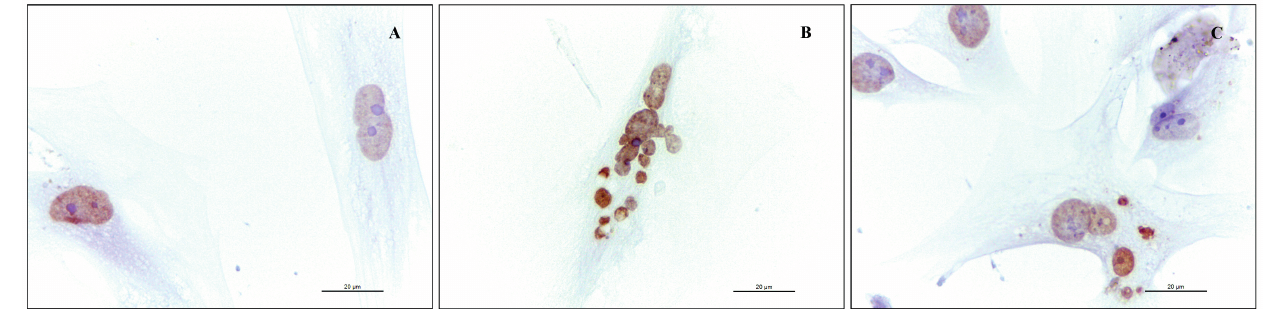
Figure 4. Cytological visualization of apoptosis by TUNEL assay on P20 pre-adipocytes. Nuclei of apoptotic cells are marked in brown, counterstained with Gill’s hematoxylin. ( A ) CTRL cells; the nuclei are clearly positive, partly demonstrating alteration of nuclear membrane; ( B ) RS-treated pre-adipocytes; extrusion of apoptotic nucleus, presence of apoptotic bodies and nucleus fragmentation; ( C ) RR-treated pre-adipocytes; positive nuclei with condensed chromatin and apoptotic